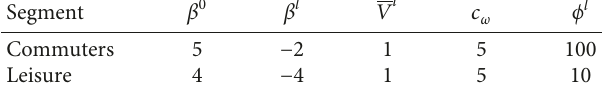
Table 3: Choice model